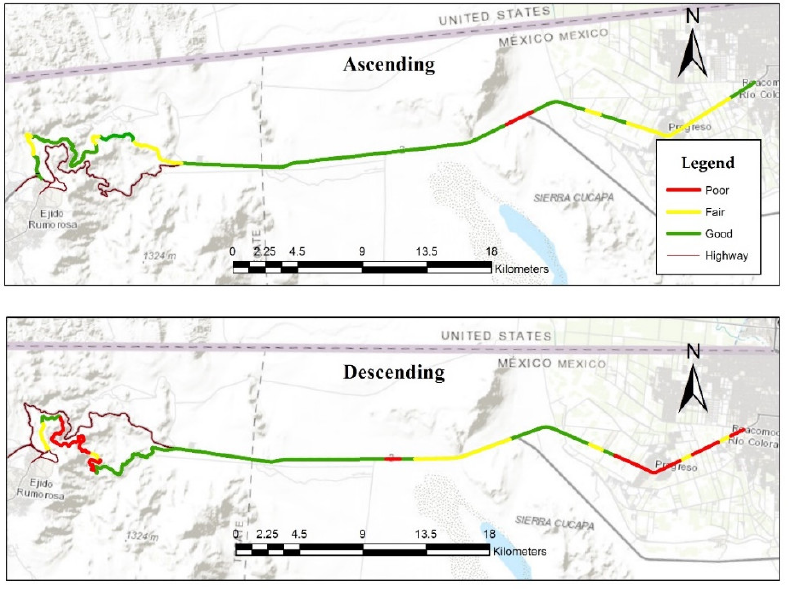
Figure 5. Pavement surface conditions.